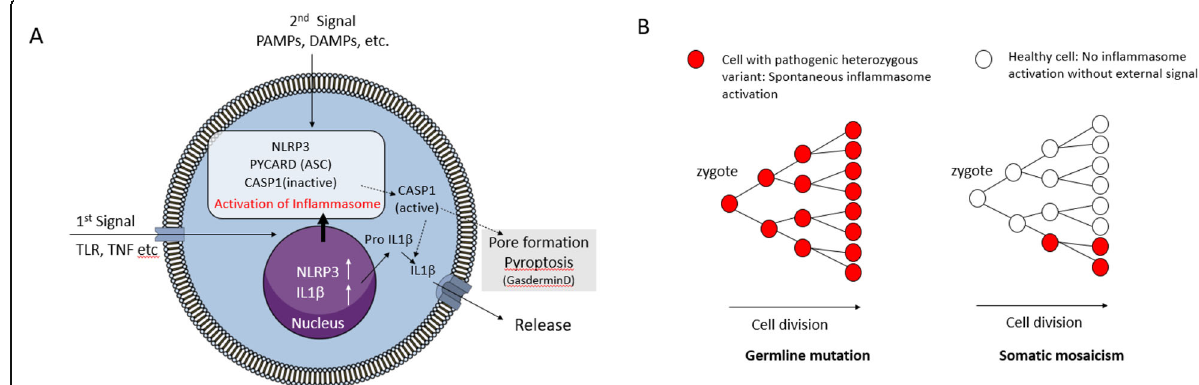
Fig. 3 NLRP3 inflammasome activation and somatic mosaicism. PAMPs, pathogen-associated molecular pattern molecules; DAMPs, damage- associated molecular patterns; TLR, toll-like receptor; TNFR, tumor necrosis factor receptor. A A simplified schema of the NLRP3 inflammasome activation is illustrated based on a previous study [35]. After NLRP3 inflammasome is activated, activated caspase 1 converts pro IL-1 β to mature IL-1 β and induces pore formation leading to pyroptosis via activation of gasdermin D. Activated IL-1 β and other cytoplasmic materials are released through the pore, thus generated. B Comparison of germline mutation and somatic mosaicism. While heterozygous NLRP3 mutation in a zygotic cell is transmitted to all the somata, somatic mosaicism takes place by post-zygotic mutation in NLRP3 in CAPS and thus a small fraction of the somata carry the pathogenic NLRP3 variant. Cells with pathogenic NLRP3 variant are reported to spontaneously activate